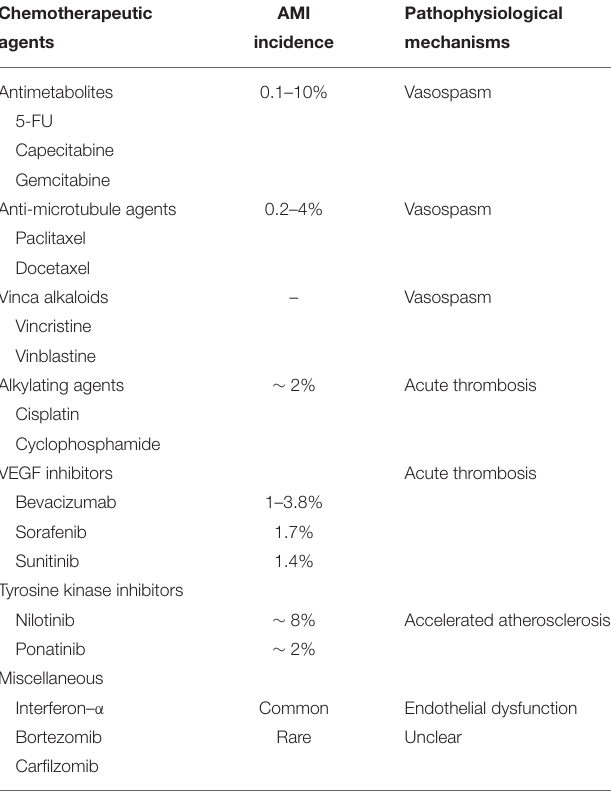
TABLE 1 | Correlations among chemotherapy, AMI incidence, and